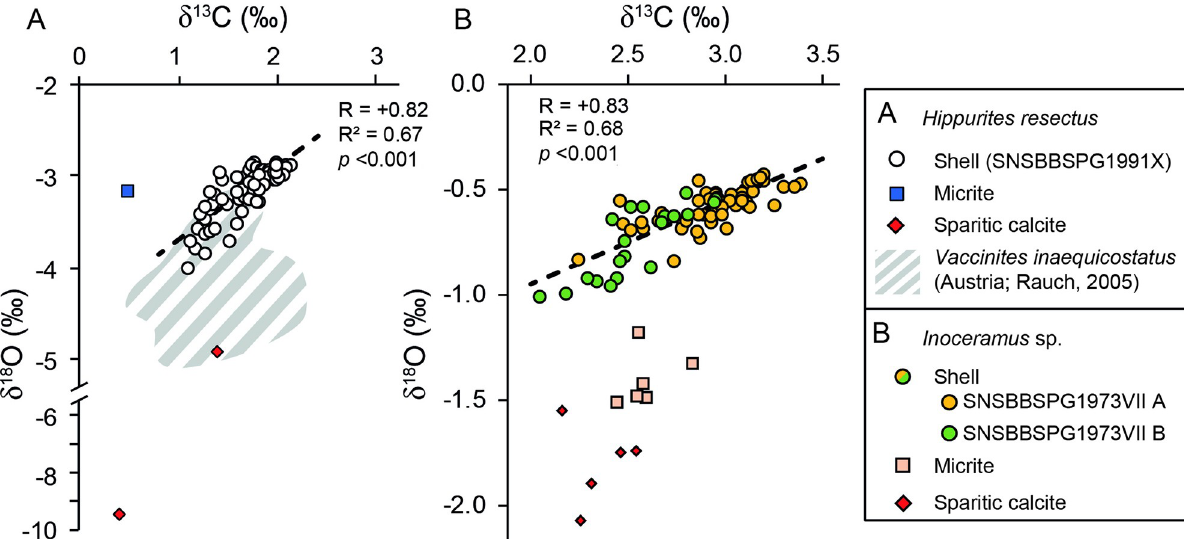
Fig 3. Plots of the δ 13 C and δ 18 O values of the carbonates analyzed in this study. These include burial sparite, micrite, and the low-Mg calcite shells of the studied inoceramid and rudist material. (A) The stable isotope values of the Hippurites resectus shell are positively correlated (R = +0.82; R 2 = 0.67; p -value < 0.001) and plot in the upper range of previously published δ 13 C and δ 18 O values of coeval the Vaccinites inaequicostatus rudists [65] (shaded area). (B) The studied Inoceramus sp. specimens also display a positive correlation (R = +0.83; R 2 = 0.68; p -value < 0.001) and does not overlap with the stable isotope values of diagenetic altered phases (micrite and